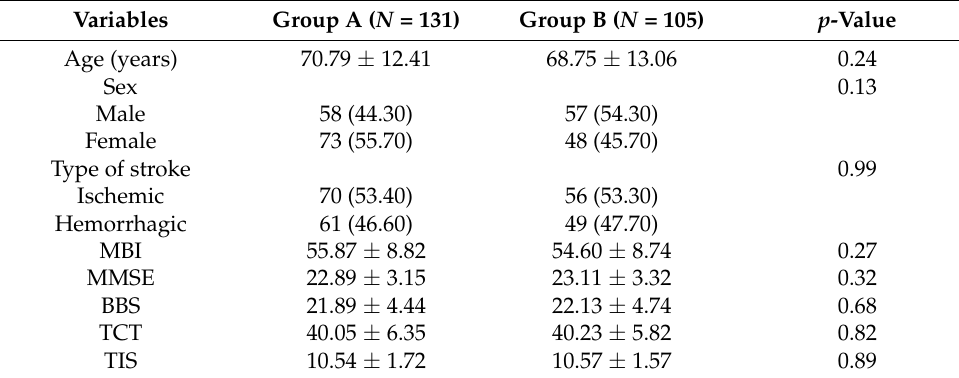
Table 2. Baseline characteristics of the two groups.